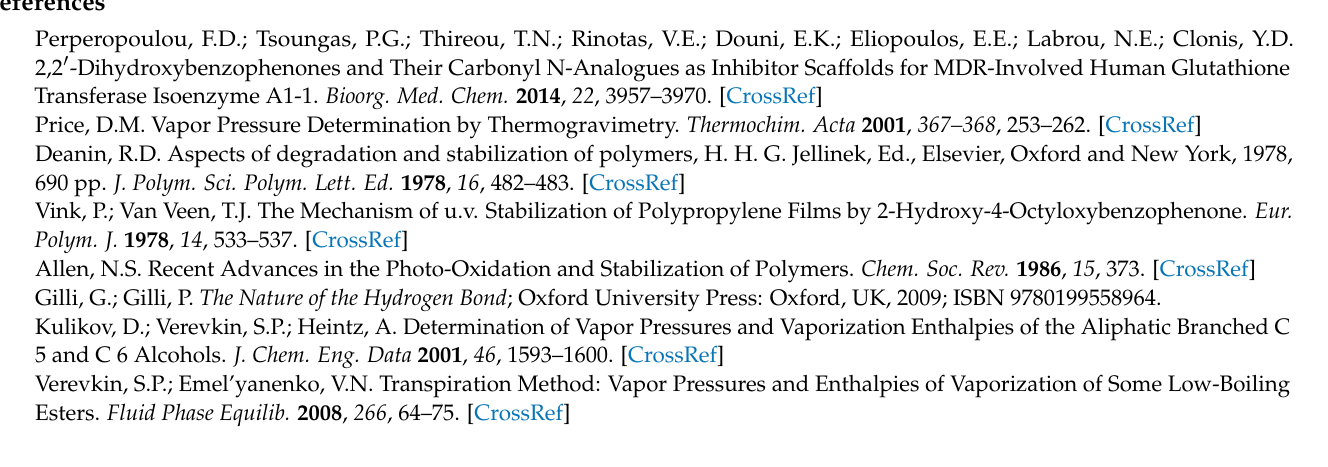
Table S1. Thermochemical data at T = 298.15 K for auxiliary reference compounds; Figure S1. The stable conformers of hydroxy- and methoxy-substituted benzophenones; Figure S2. Determination of the intra-molecular hydrogen bonding strength in substituted benzophenone using the “well- balanced reaction” method; Enthalpy of fusion measurements. References [7–10,20,31,32,46,55,58–64] are cited in the Supplementary